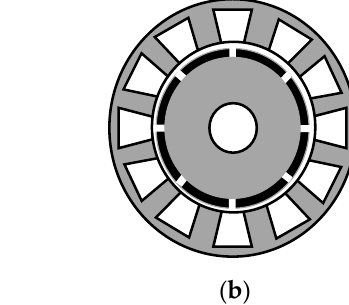
Figure 1. Structure of permanent magnet synchronous motor (PMSM). ( a ) Interior permanent magnet synchronous motor (IPMSM) and ( b ) surface-mounted permanent magnet synchronous motor (SPMSM).